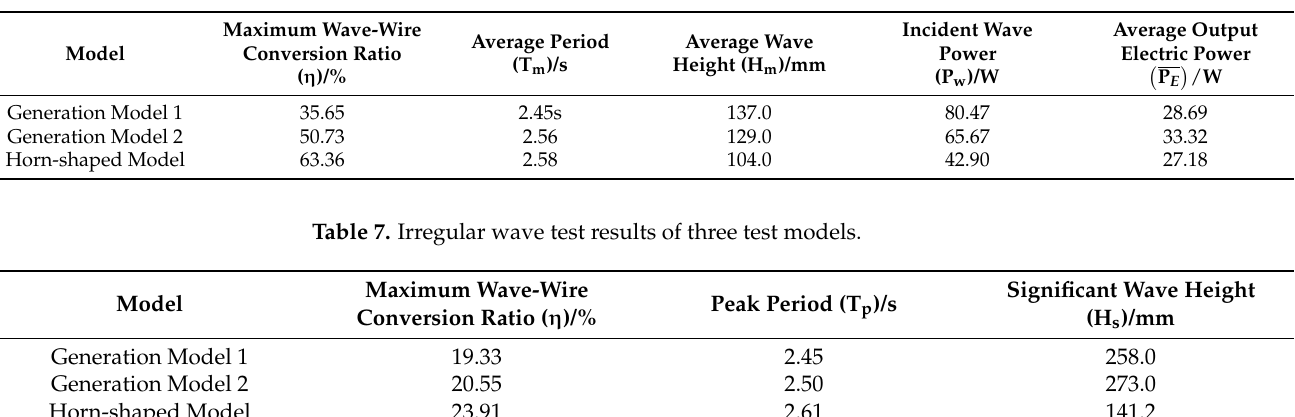
Table 6. Regular wave test results of three test models.